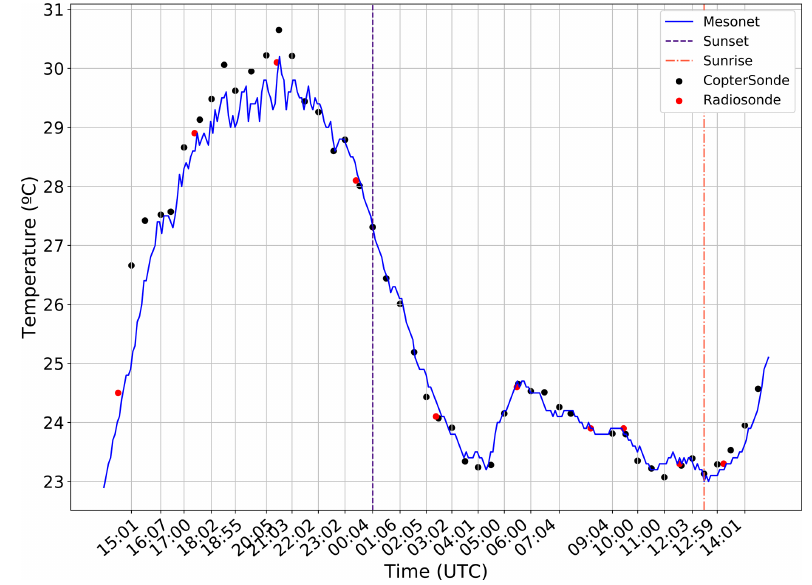
Figure 2. Time series of temperature ( ◦ C) measured at the lowest level from the Mesonet (9m; blue line), CopterSonde (6m; black dot), and radiosondes (7m; red dot) on 5–6 October 2018. Purple and orange vertical lines represent sunset and sunrise,